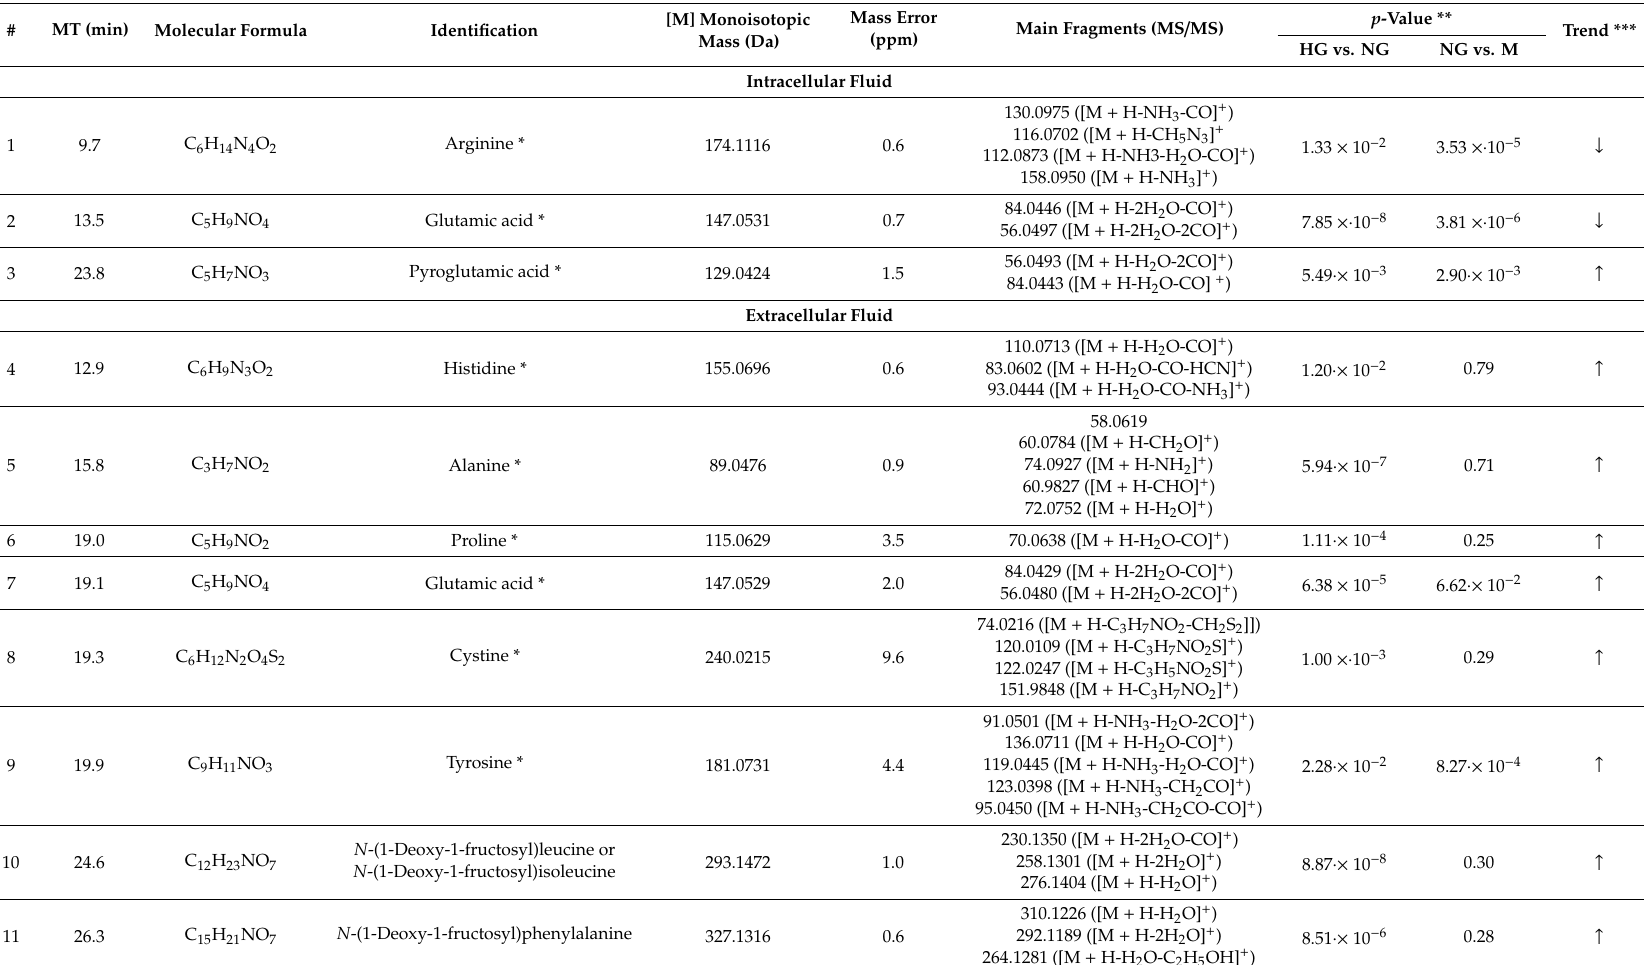
Table 2. Metabolites identified in the intracellular and extracellular analysis by the CE-MS metabolomics